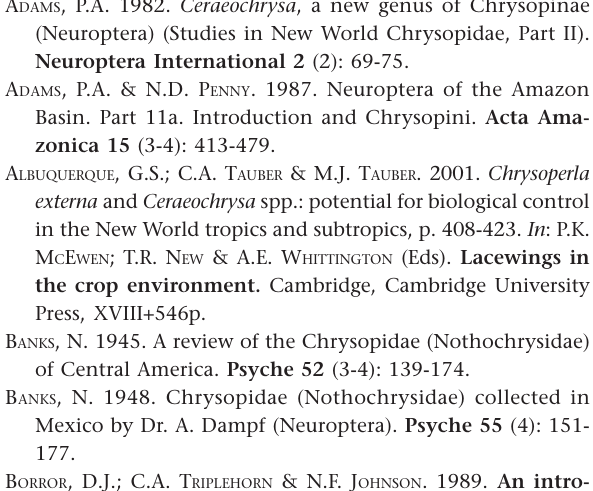
obtida em labora- 1